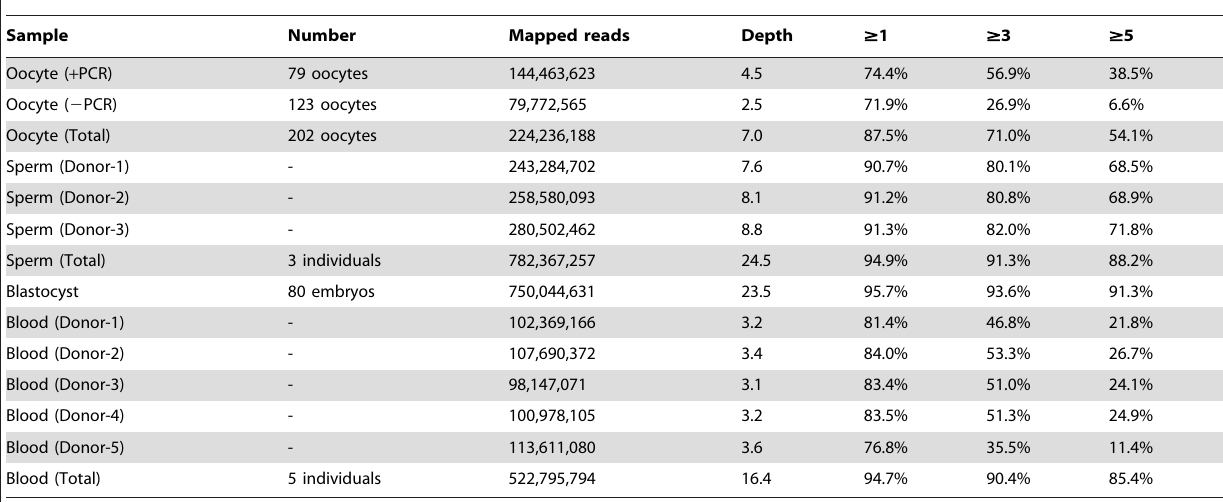
Table 1. Summary of whole genome bisulfite